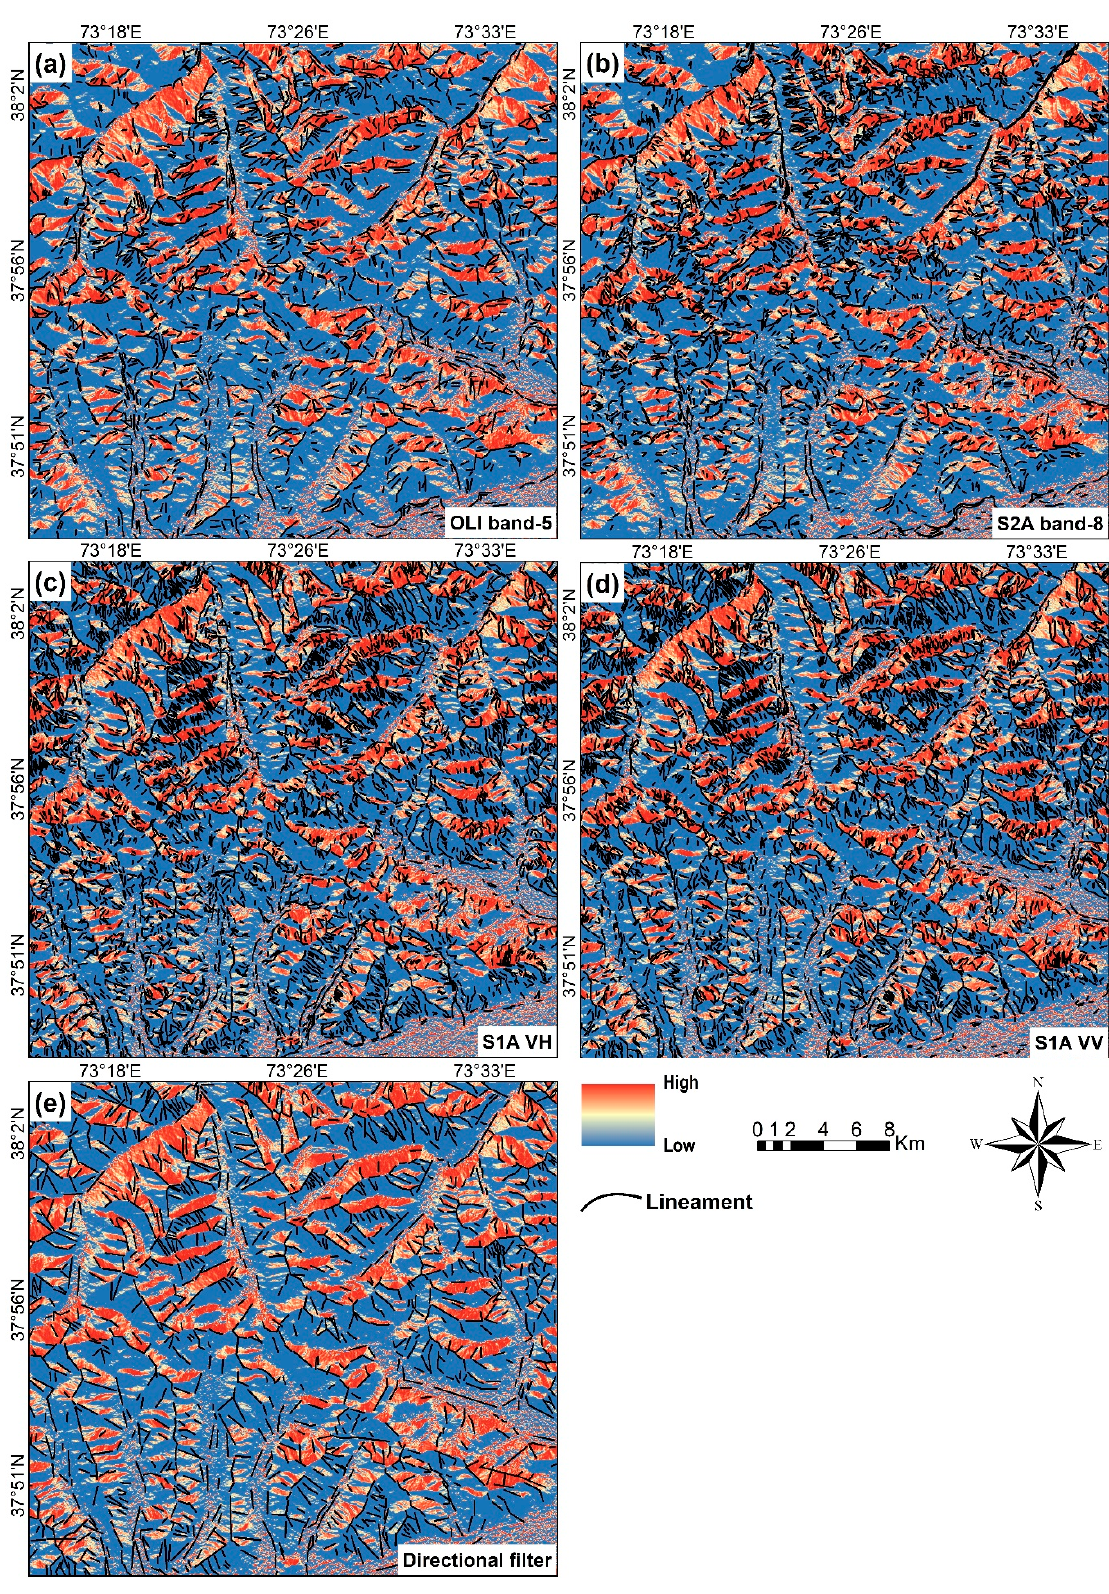
Figure 11. The superposition of lineaments extracted automatically from ( a ) OLI band-5, ( b ) S2A band-8, and ( c , d ) S1A VH and VV polarizations respectively, in addition to the ( e ) lineaments extracted manually from the directionally filtered RGB color composite image on the Shaded relief thematic map: The colour coding denotes the shaded (high value) and unshaded (low value) areas.